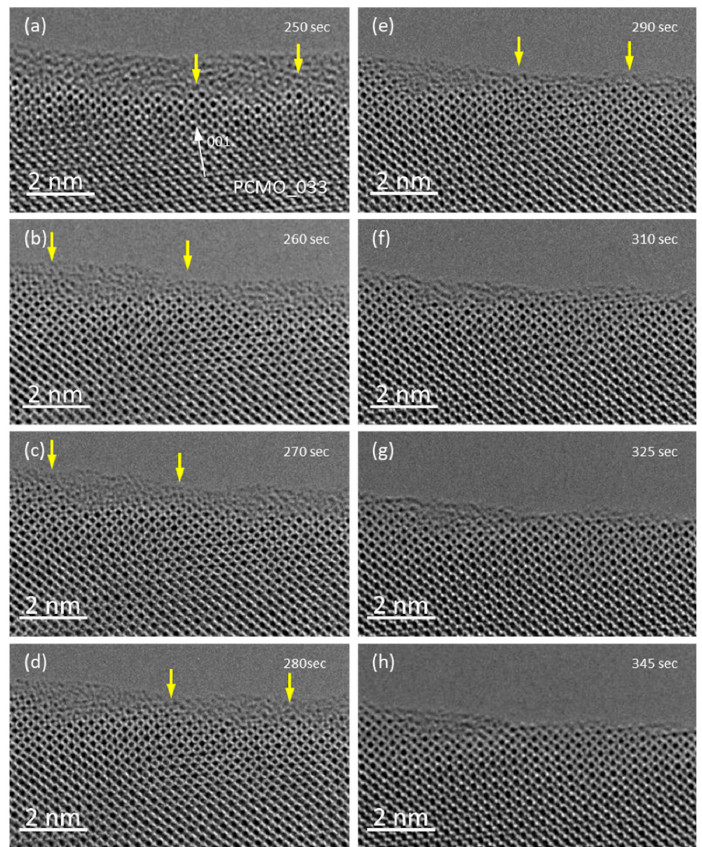
Figure 3. A series of images showing transformation of amorphous edge of PCMO (x = 0.33) into crystalline structure. The images were collected in O 2 , p O2 = 50 ubar. ( a ) During several minutes only mobility of atoms in amorphous layer is visible. ( b – d ) The growth of small island of pyramidal shape is observed (the place is marked with the yellow arrow). ( e )These pyramids grow slowly and reach the surface of amorphous layer. Its thickness becomes smaller at the same time. Finally, amorphous areas between pyramids also transform in crystalline perovskite oxide phase, and flat facets up to 10 nm in length are formed ( f – h ).